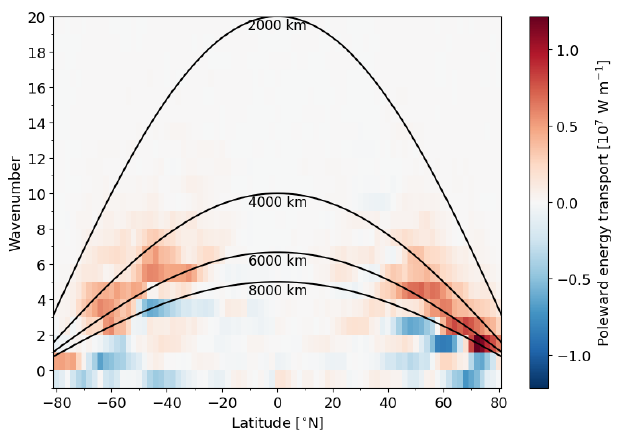
Figure 3. The composite of the anomalous poleward energy trans- port by individual waves ( [ vE ] n of Eq. 11) at different latitudes 4d after situations of anomalous high (90th percentile) meridional temperature contrasts around the latitude of energy transport. The anomalies on a daily resolution are computed from the 21d and 9- year running-mean climatology. The meridional temperature con- trast is computed by the difference between the zone 10 ◦ equa- torward and 10 ◦ poleward of the latitude of interest. Hence, red colours denote waves transporting more energy polewards 4d af- ter situations of enhanced meridional temperature differences. The wavenumbers corresponding to wavelengths of 2000, 4000, 6000, and 8000km are depicted by black lines. Wave 0 is corrected by the meridional mass flux to express the instantaneous zonal-mean transport according to Lembo et al.